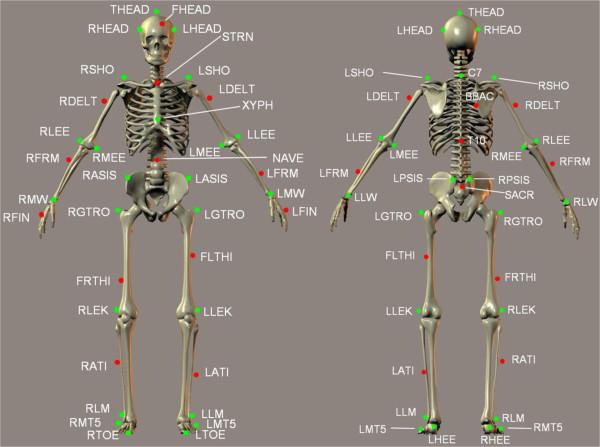
The Human Body Model is defined by 47 surface markers attached over bony landmarks, for details see [15].